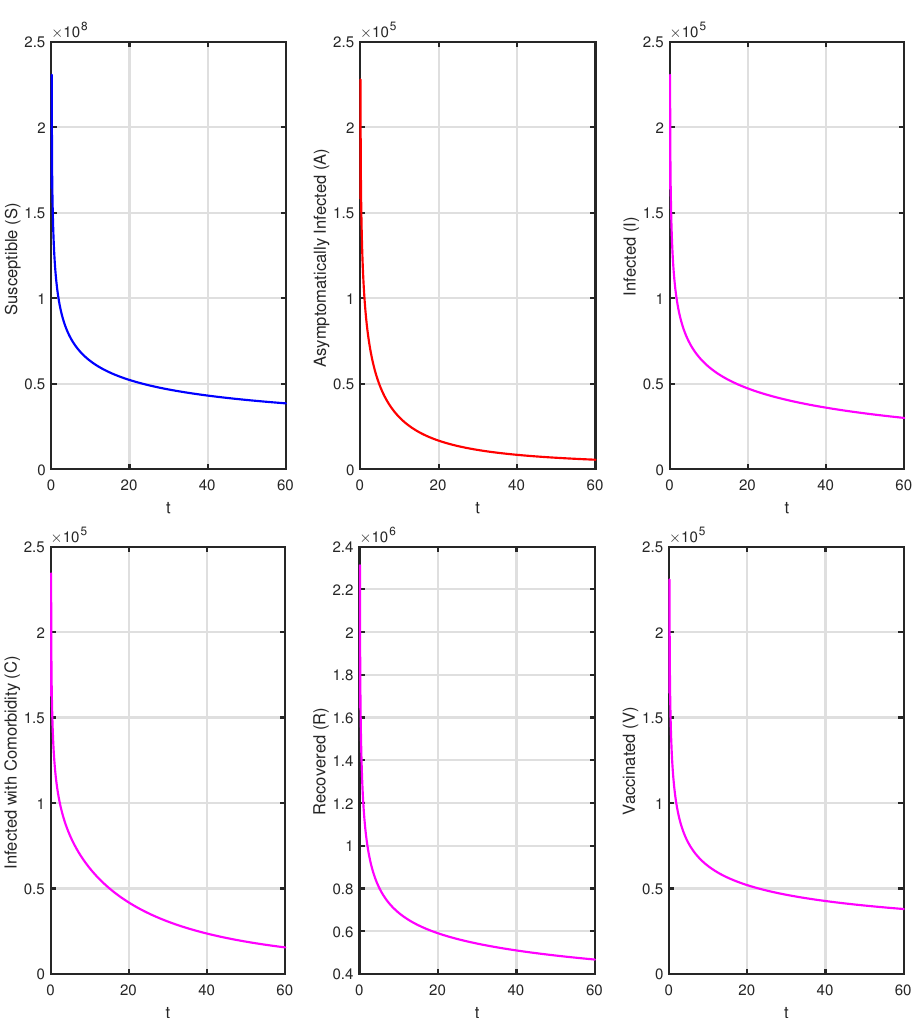
Figure 4. Time series of state variables when no control is